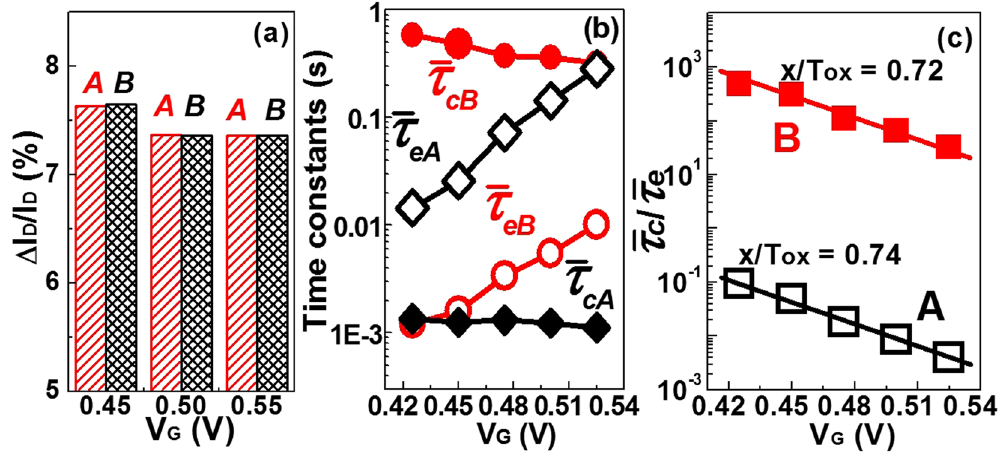
Figure 4. The comparisons of ( a ) amplitudes, ( b ) time constants and ( c ) the extracted trap position in zone A and zone B. The results suggest that zone A and zone B represent the same single oxide trap in the gate